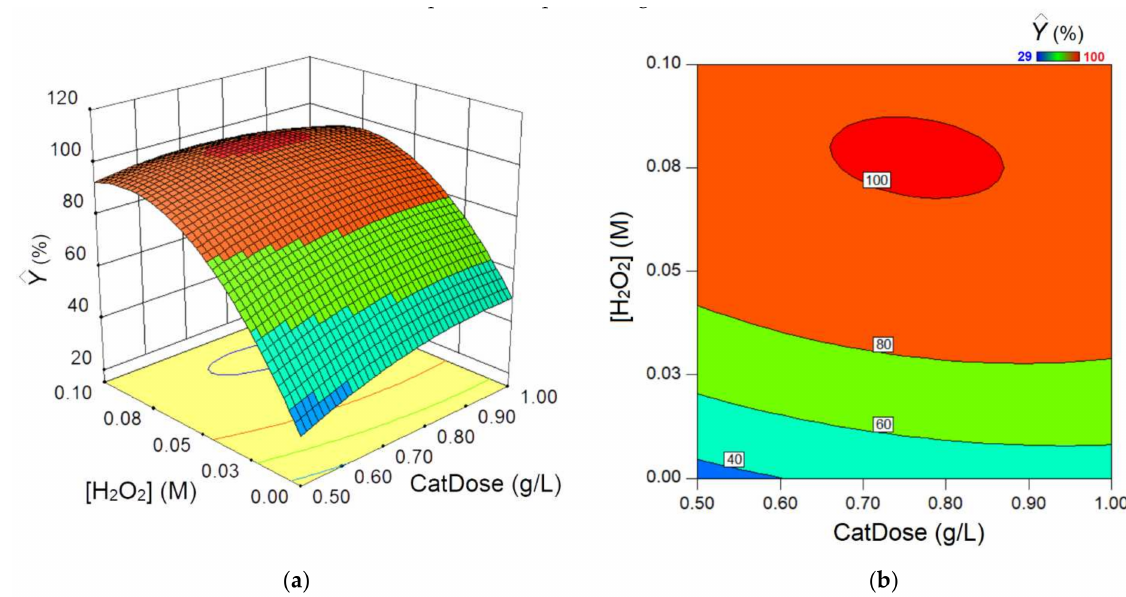
Figure 10. Response surface 3D plot ( a ) and contour-lines 2D map ( b ) showing the mutual effect of CatDose and (H 2 O 2 ) factors on the estimated process response ( ˆ Y ,